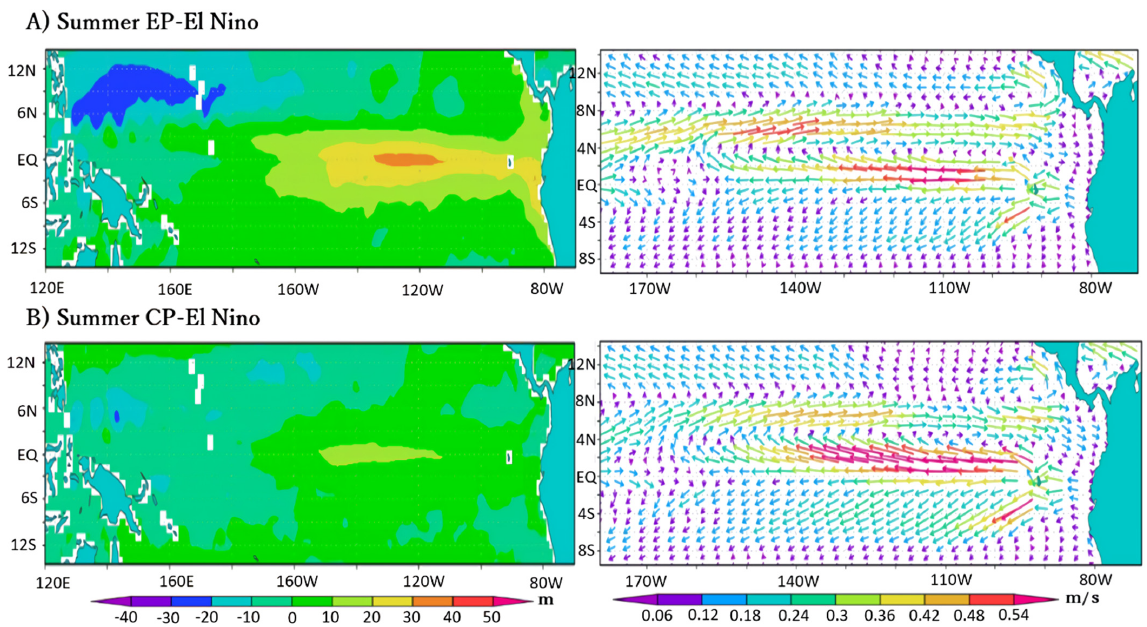
Figure 9. Composite maps of 20 °C isotherm depth (D20) anomalies (left panel) and ocean surface current (right panel) for the summer from ( A ) the EP El Niño and ( B ) CP El Niño. Negative (Positive) D20 anomalies denote shoaling (deepening).